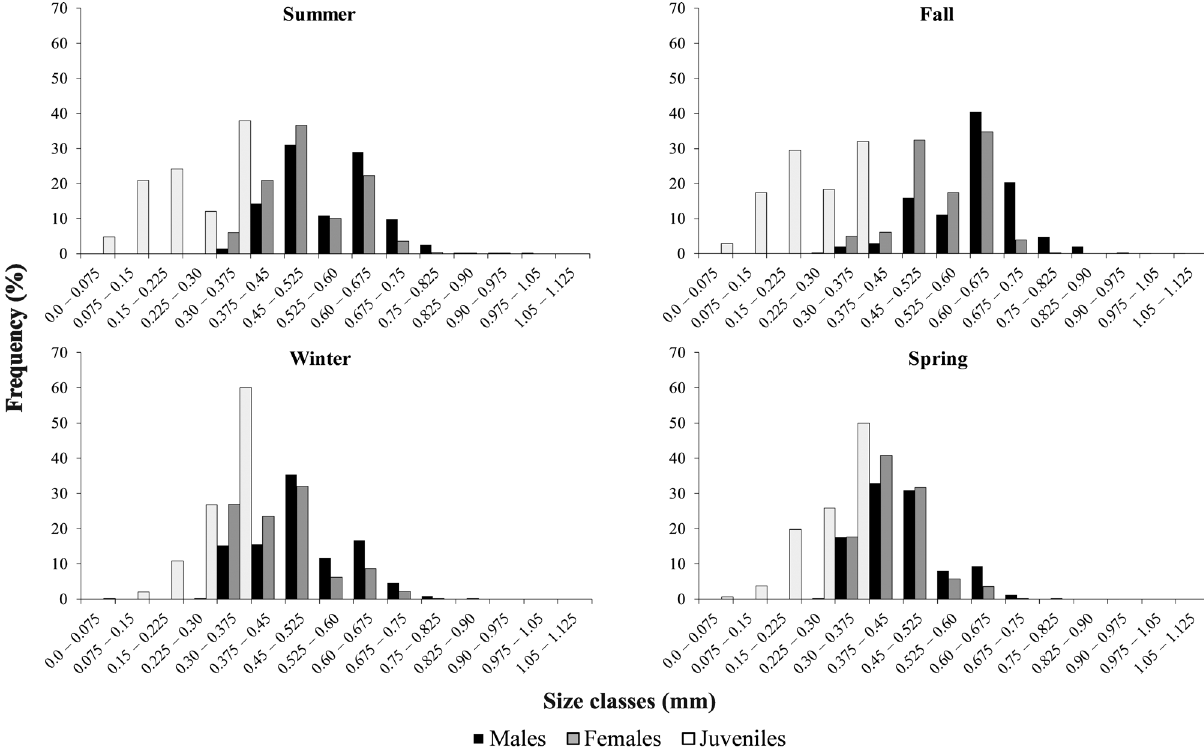
Figure 3. Seasonal size-frequency distribution of males, females and juveniles of Hyalella gauchensis , Palmeira das Missões, state of Rio Grande do Sul. Brazil. All sizes shown in the graph have at least one measured